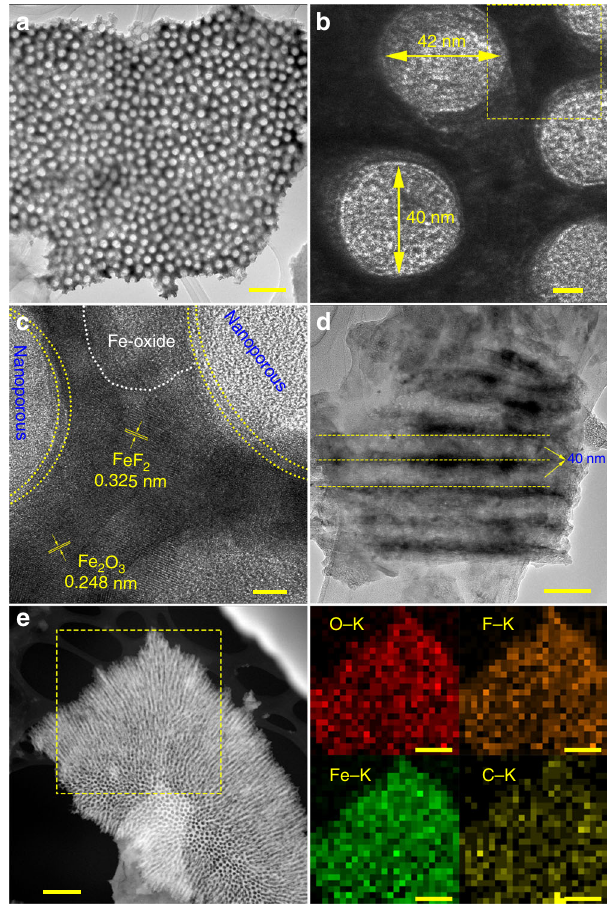
Fig. 2 Microscopic morphology and chemical composition of IFONFs-45. a TEM top-view images of IFONFs-45. Scale bar, 200 nm. b , c HRTEM images of IFONFs-45. Besides amorphous nanodomains, the lattice fringes with spacing of ~0.325 and 0.248 nm ascribed to FeF 2 (110) and Fe 2 O 3 (400), respectively, are clearly visible, indicating crystallinity of iron fl uoride-oxide nanostructure. The nanopores, together with fi ne nanograins of iron fl uoride-oxide and thin amorphously shells are uniformly distributed in the porous network, ensuring IFONFs-45 has more accessible sites for electrochemical reactions. Scale bar, 10 and 5 nm, respectively. d TEM cross-sectional image of IFONFs-45. Scale bar, 100 nm. e STEM elemental mapping of IFONFs-45. Scale bar, 500